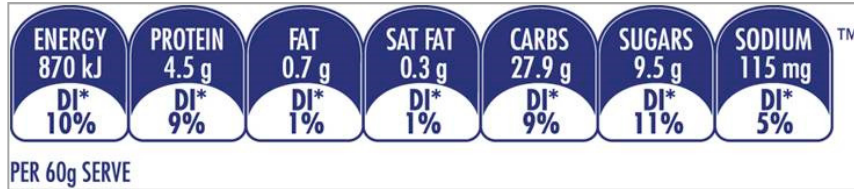
and the content of four nutrients (sugar, fat, saturated fat and salt) in grams and as a percentage of